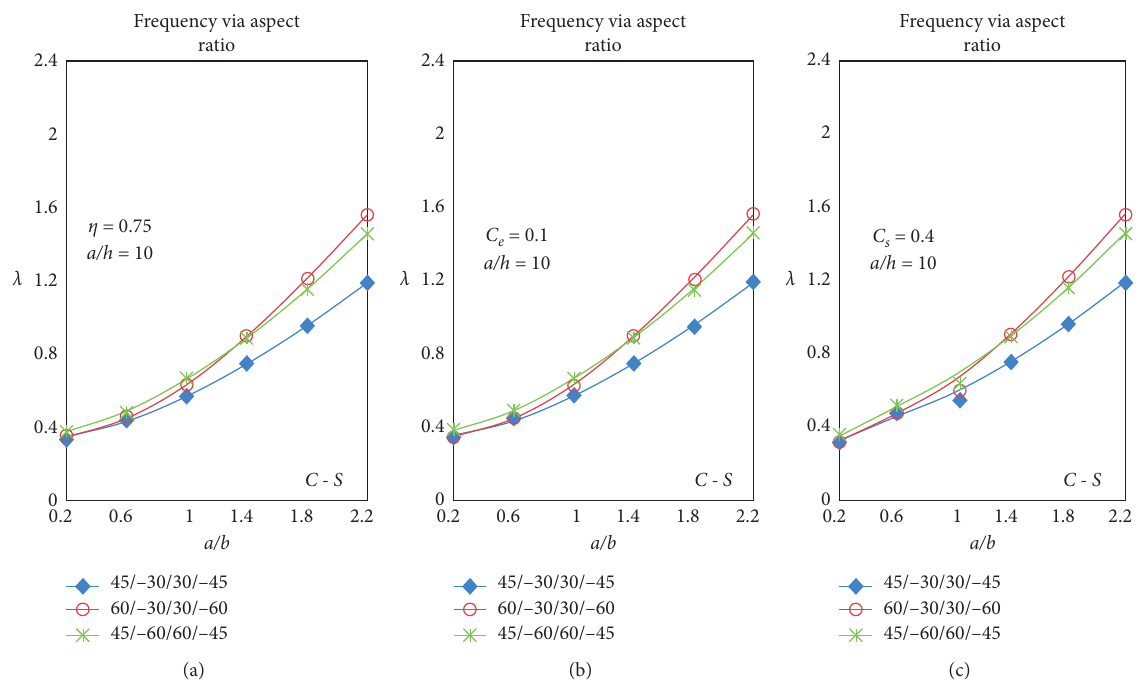
Figure 13: Influence of aspect ratio on frequency parameter value of 4-layered plates under C-S support condition.